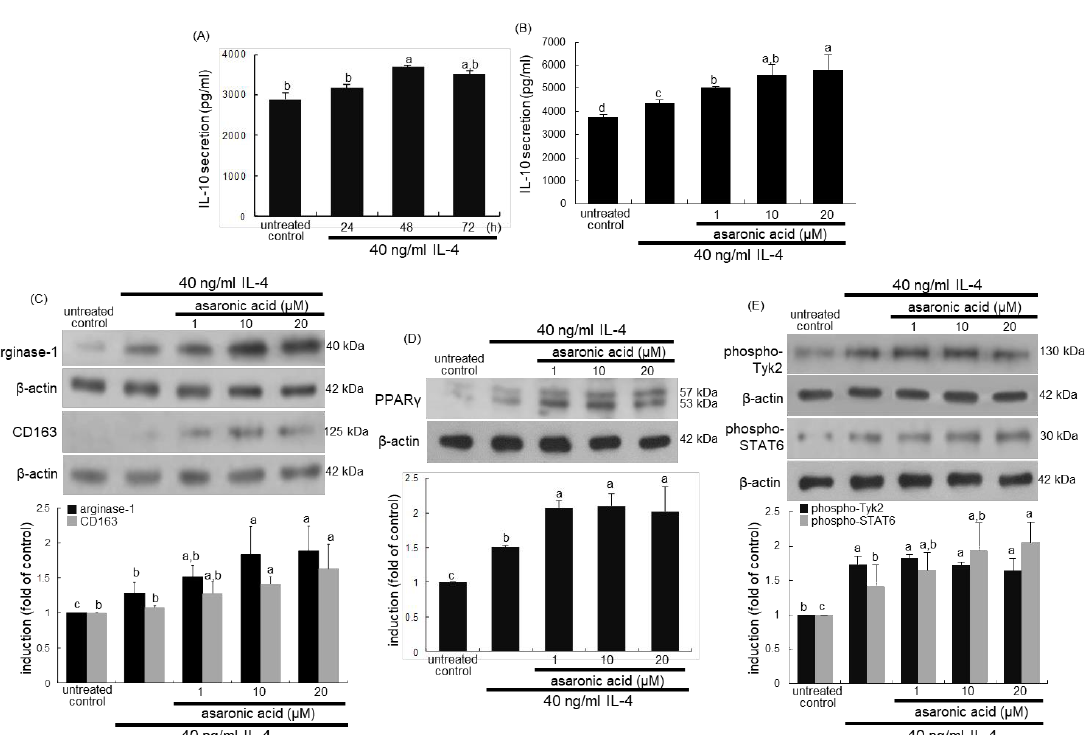
Figure 2. ELISA data showing temporal response and upregulation of IL-10 secretion ( A , B ) and Western blot data showing upregulation of expression of arginase-1, CD163, PPAR γ , phospho-Tyk2, and phospho-STAT6 by asaronic acid ( C – E ). J774A.1 macrophages were exposed to 40 ng / mL IL-4 in